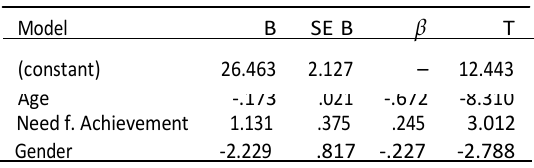
Table 1. Linear regression table for average performance.